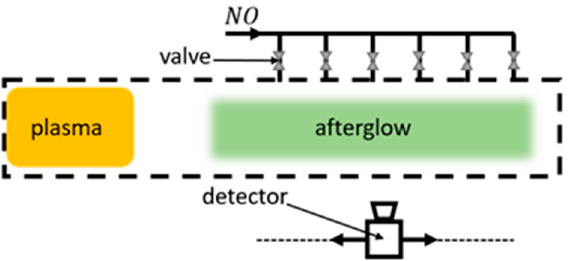
Figure 10. Schematic of a plasma system utilizing measurements with NO titration. NO gas is introduced to the system through a series of valves, and a movable detector monitors the afterglow.